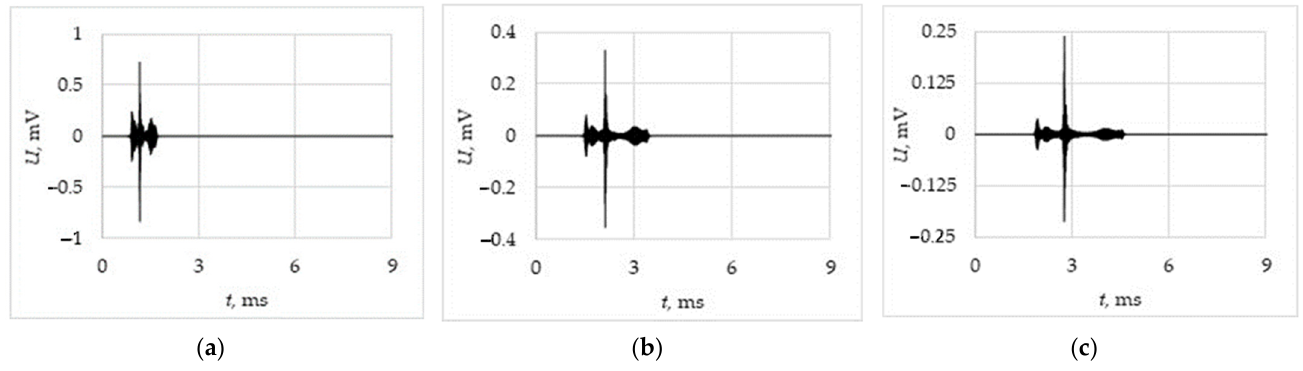
Figure 9. Modeled signals at different distance from AE source 2 m ( a ), 5 m ( b ), 7 m ( c ).